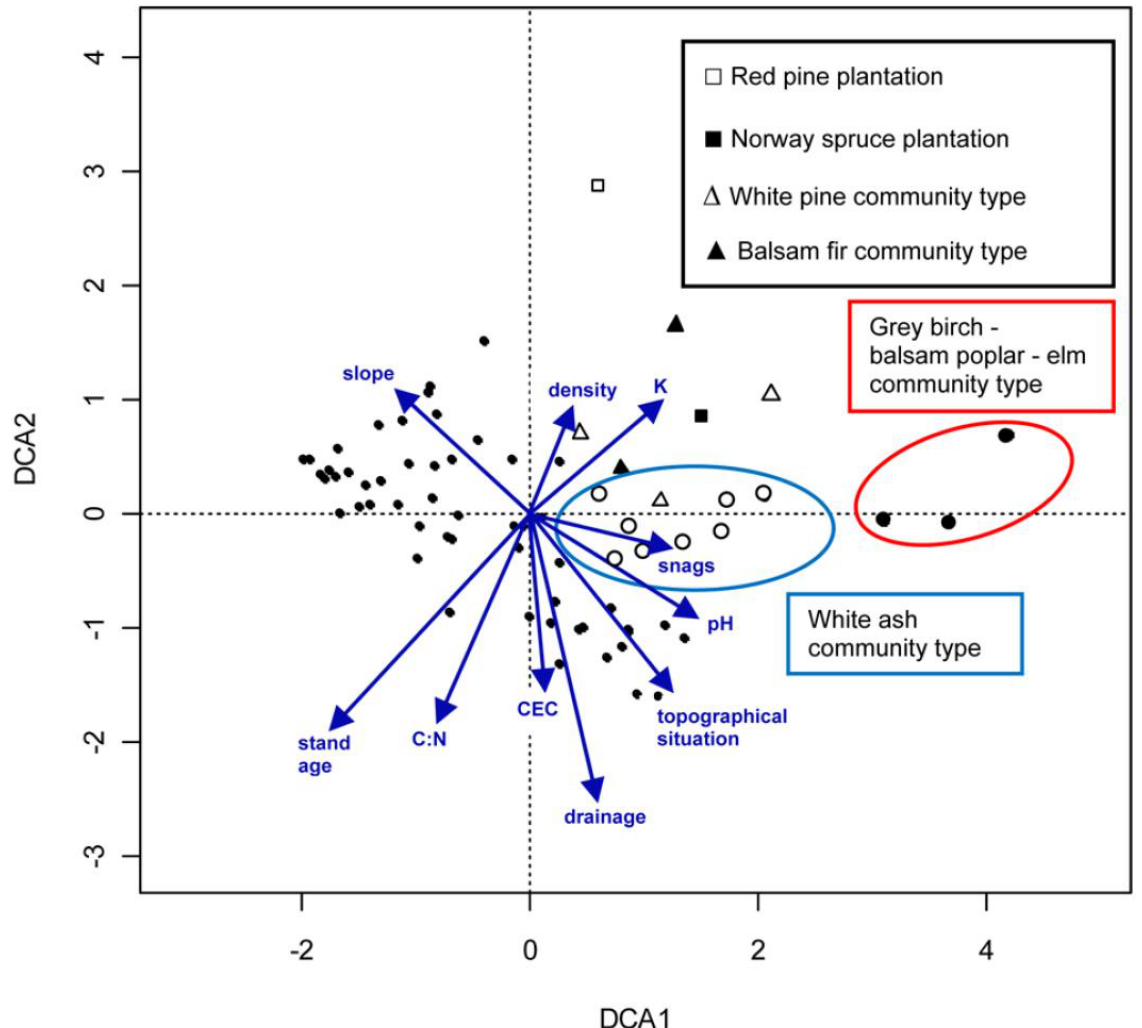
Figure 2. Detrended Correspondence Analysis (DCA) of 71 forest vegetation plots at St-Benoît-du-Lac Abbey. This first ordination helped identify a few atypical or unique plots (red pine plantation, Norway spruce plantation) as well as 4 forest community types that are not common in the study area and/or with younger stand age (total of 18 plots). Ecological factors most strongly correlated with both axes are represented by vectors. Abbreviations: slope = percent slope; density = tree density/ha; K = soil K; snags = density of hardwood snags; pH = soil pH; drainage = soil drainage class (rapidly drained to poorly drained); CEC = soil cation exchange capacity; C:N = soil C:N ratio; stand age = age of largest